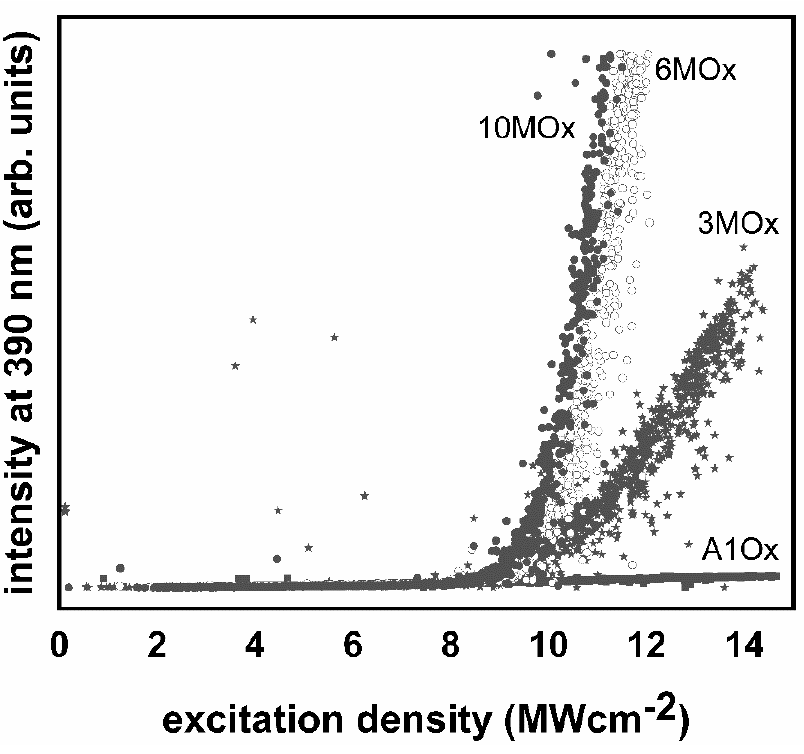
Figure 6. Random lasing probability: the photoluminescence signal of the four samples, centered at 390 nm, is collected in a reflection experimental configuration.